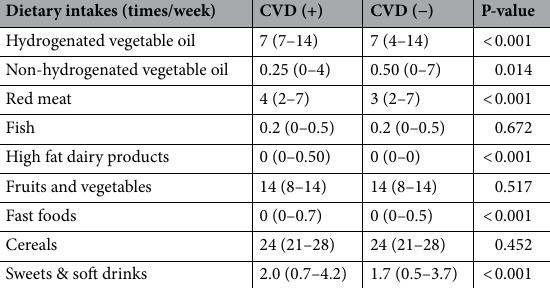
Table 3. Dietary intakes in participants with cardiovascular disease. Data are expressed as median (Q1–Q3) due to non-normality. Comparison was obtained from Mann–Whitney test.